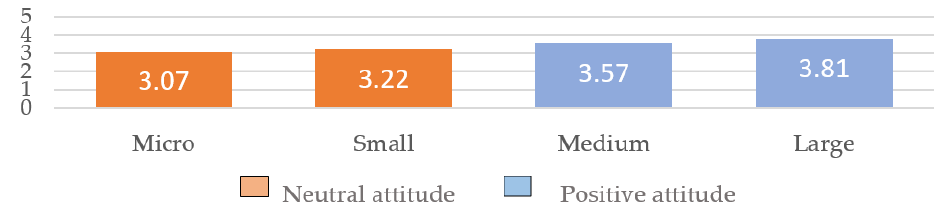
Figure 3. Attitude towards AI among employees according to company size.